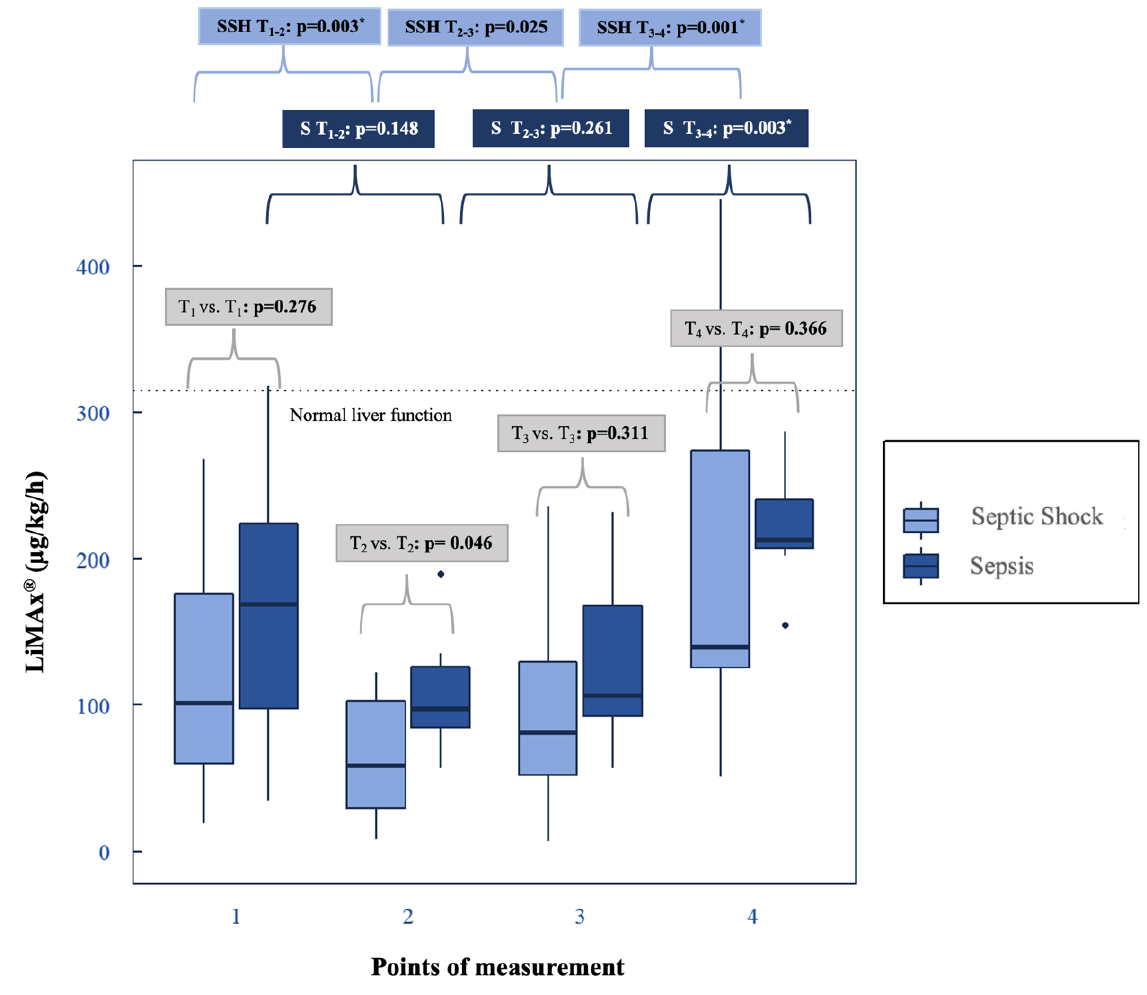
Figure 2. LiMAx ® : sepsis vs. septic shock and the progression in the subgroups. LiMAx ® : grey rectangle: p -values of septic shock vs. sepsis; dark blue rectangle: p -values of the subgroup sepsis (S); light blue rectangle: p -values of the subgroup septic shock (SSH); *: statistically significant. Box- whisker plot: bold lines: medians; box plots: 25th to 75th percentiles; box-whisker plots: illustrate median value with interquartile range; outliers are shown as separate points.